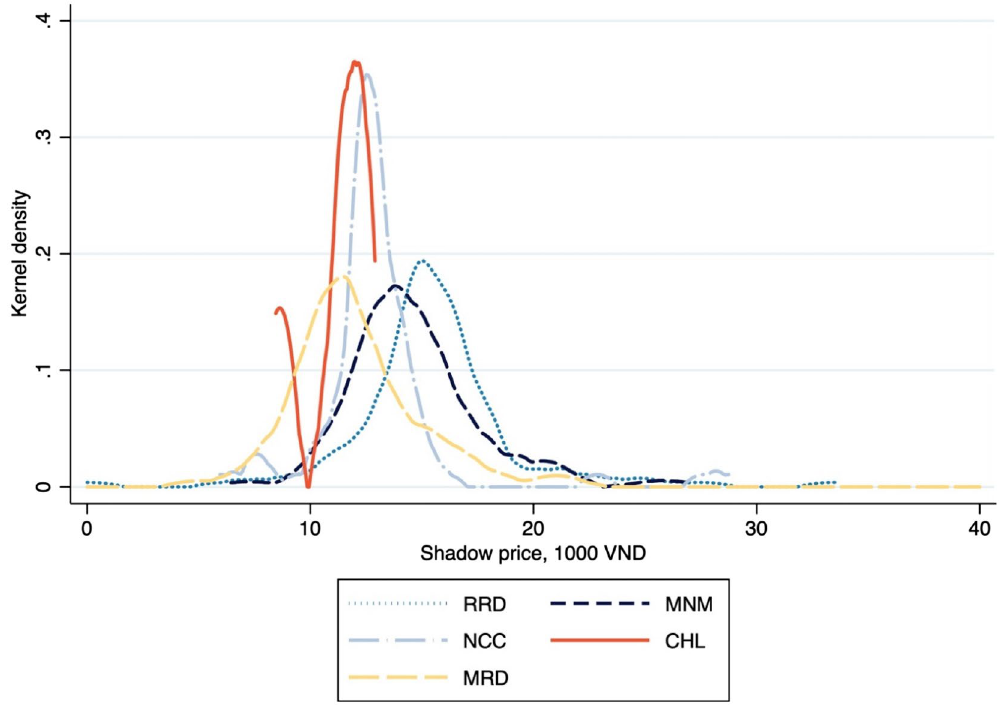
Figure 4. Kernel probability densities of shadow-price in rice production, by region.